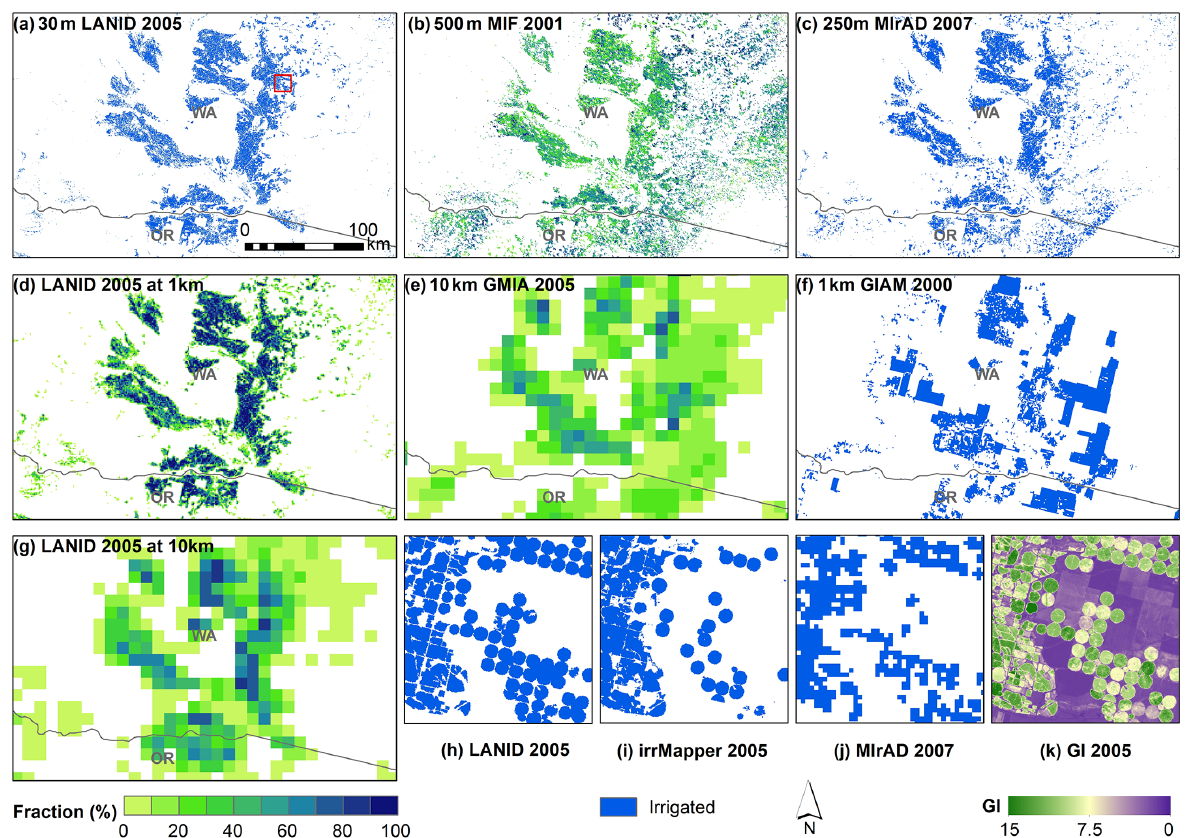
Figure 11. Product comparison at the Columbia Plateau Aquifer in northern Oregon and southern Washington. In addition to the original 30m LANID (a) , the map is aggregated to 1 and 10km resolution for panels (d) and (g) . Panels (h–i) show the location highlighted in (a) (red